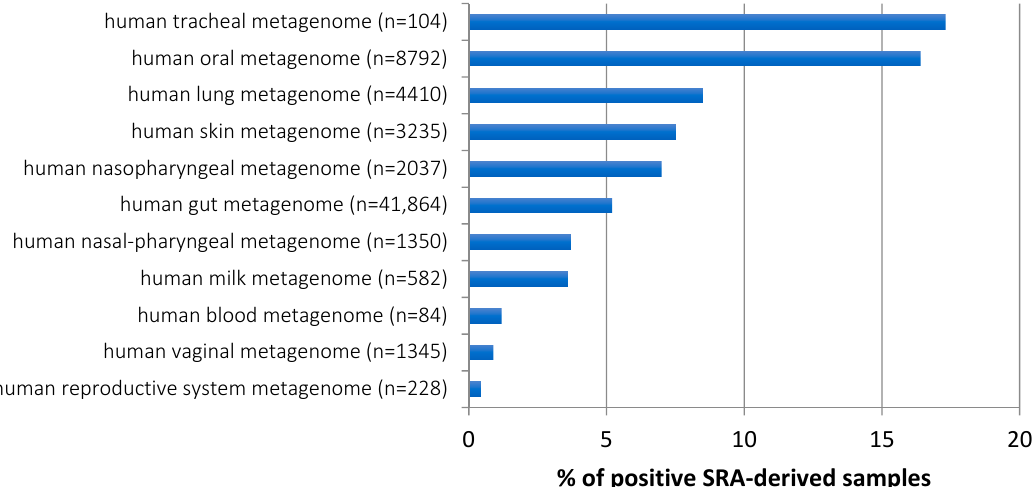
Figure 3. S. moorei detection in different human metagenomes.